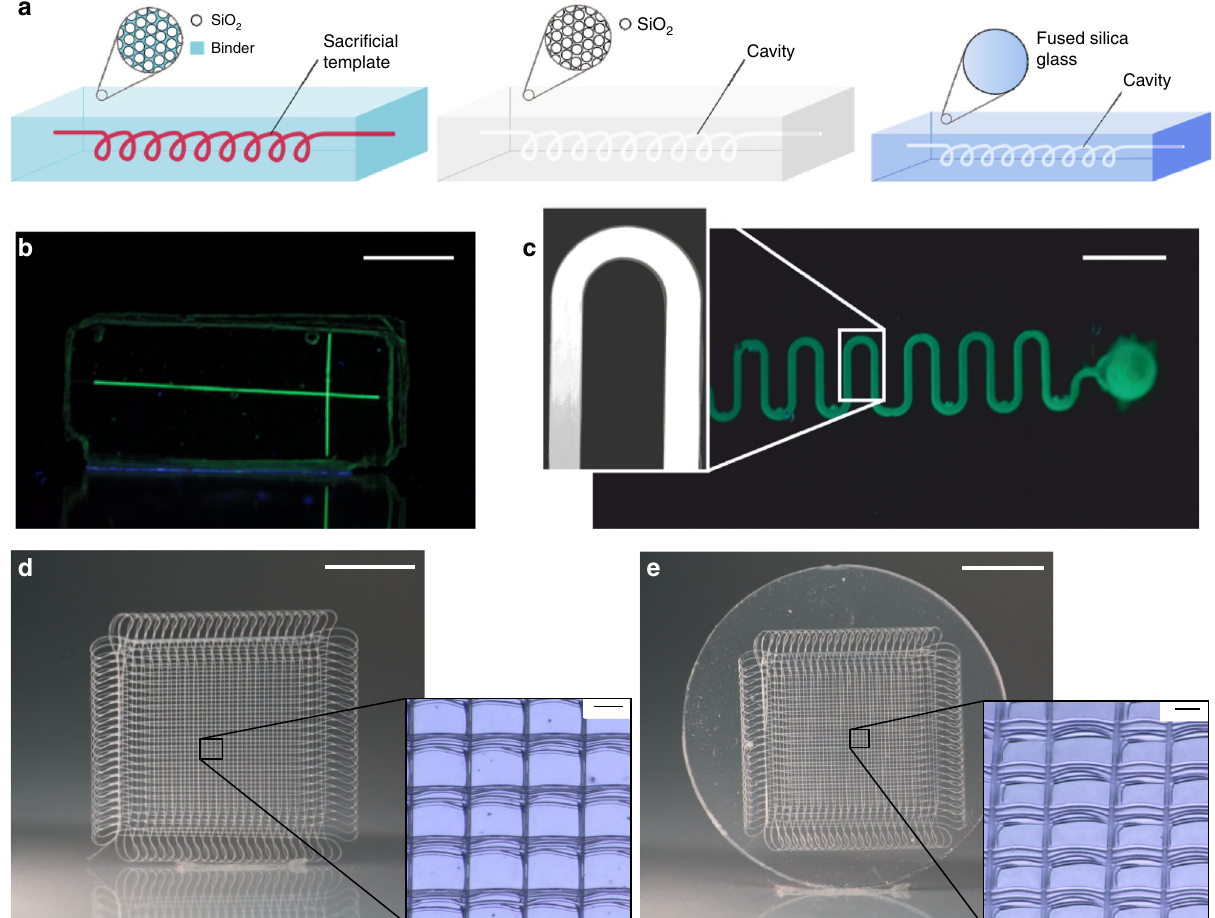
Fig. 1 Fabrication of suspended hollow microstructures in fused silica glass. a Polymeric fi laments are embedded in an amorphous silica nanocomposite. The polymerized nanocomposite is turned into fused silica glass via thermal debinding and sintering. The polymeric template is removed during the thermal debinding process and leaves the according hollow cavity. b Micro fl uidic fused silica chip fabricated by embedding a nylon thread (scale bar: 9 mm). c Micro fl uidic meander fabricated by embedding polymerized PEGDA structured by microlithography (scale bar: 11 mm). d A mesh structure made from poly( ε -caprolactone) using melt electrowriting (scale bar: 5 mm). The inset shows the microscopy image of the mesh with a fi ber diameter of 25.0 µ m (scale bar: 100 µ m). e Inverse hollow mesh structure in fused silica glass (scale bar: 4.5 mm). Inset shows the microcavities with a width of around 18.4 µ m (scale bar: 100 µ